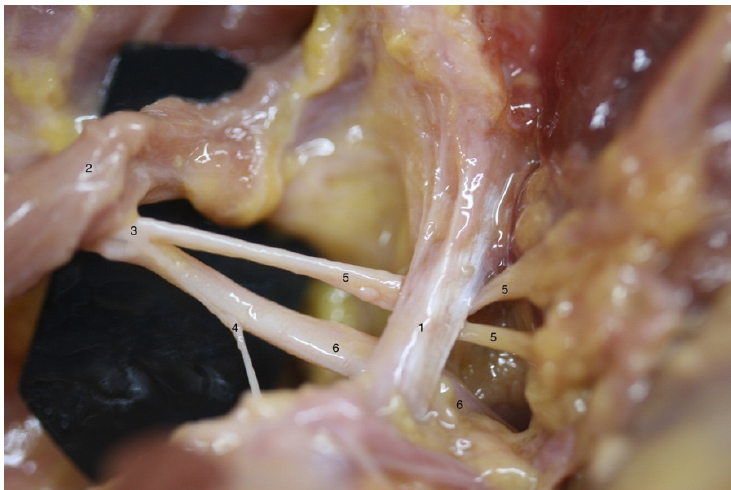
Figure 1. Anatomical variation on left shoulder from specimen C: different anatomical structures could be observed as follows: (1) superior transverse scapular ligament; (2) inferior belly of omohyoid muscle; (3) suprascapular nerve; (4) acromioclavicular sensitive branch; (5) supraspinatus motor branch; (6) infraspinatus motor branch; note that the division into supraspinatus and infraspinatus motor branches is proximal to superior transverse scapular ligament.